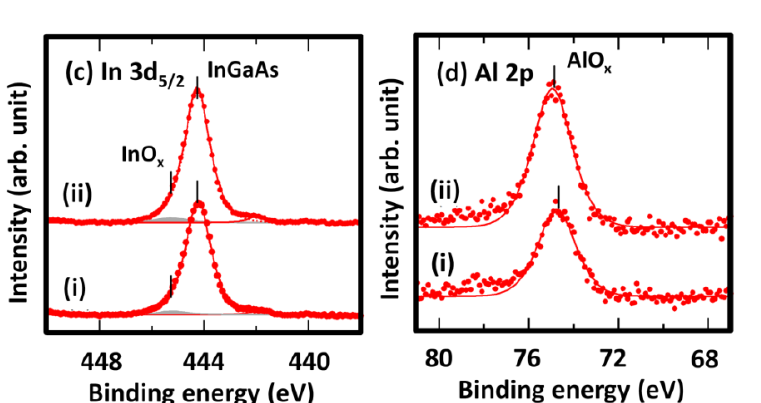
O (6 nm)/n-InGaAs(100) capacitors with ( a ) a 2 3